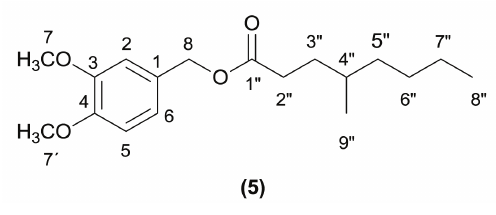
Figure 4: Chemical structure of (±)-DMBO (5). Chemical characterization of (±)-DMBO by 1 H NMR and 13 C NMR analysis.